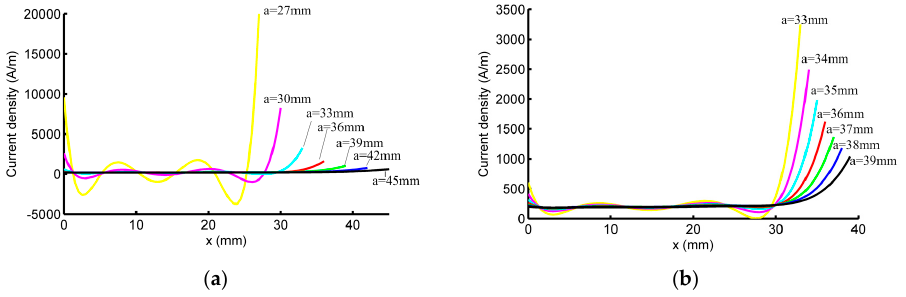
Figure 3. Optimization result: current density distribution vs. x for different values of parameter “ a ”.